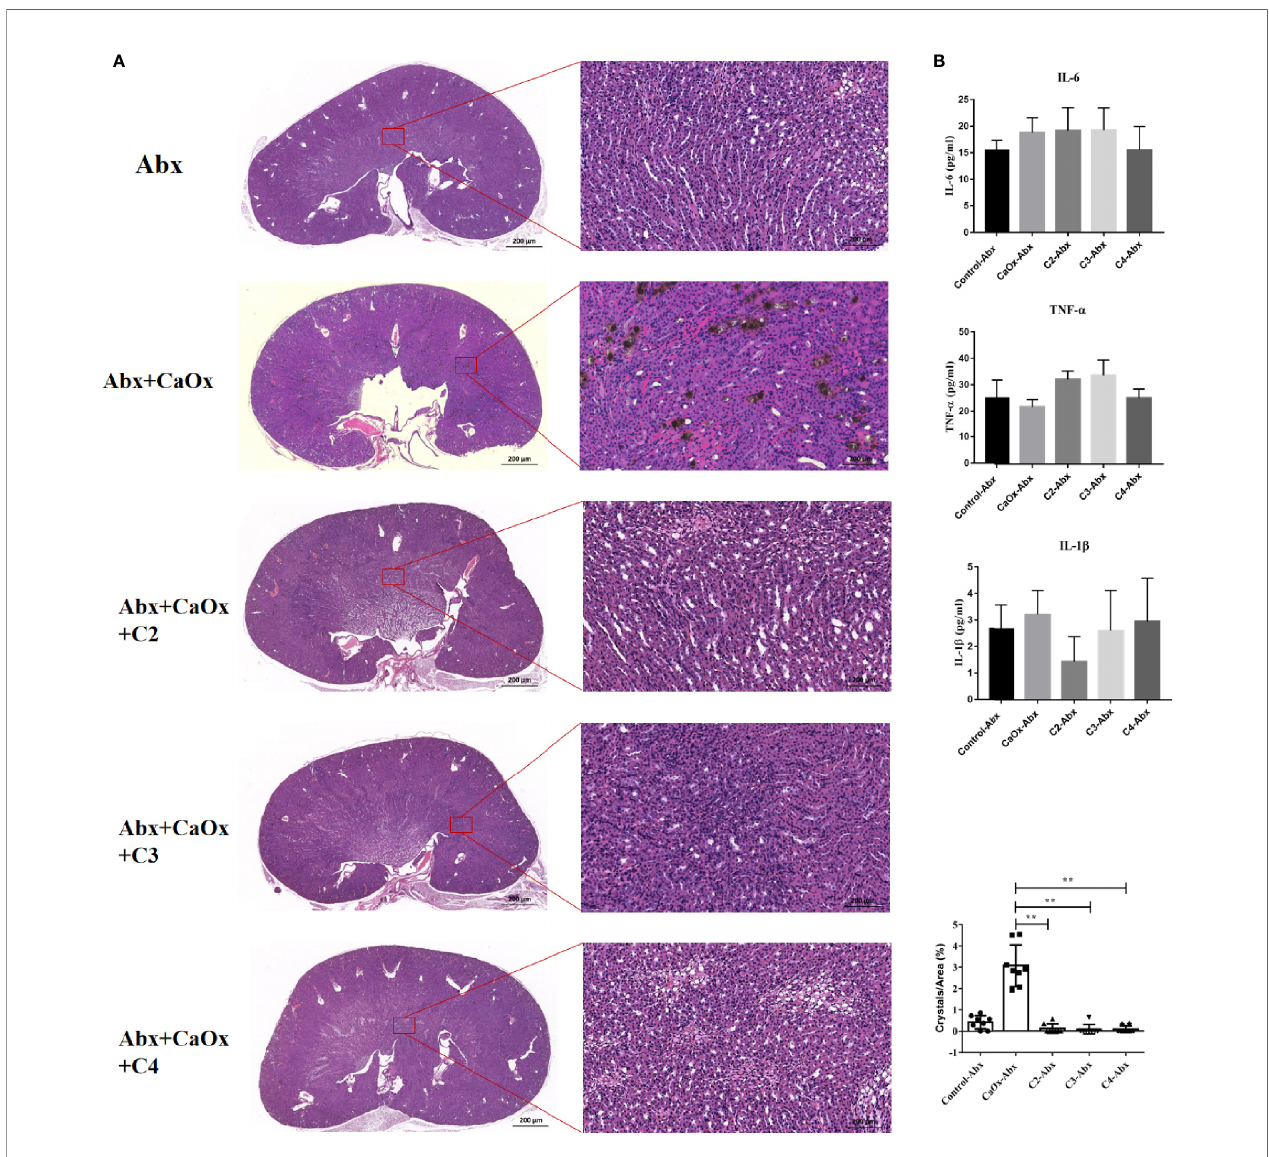
FIGURE 8 | Effect of antibiotics on renal CaOx crystal formation in mice with or without SCFAs. (A) Representative images of Von Kossa staining and HE staining in kidney of mice administrated with antibiotics and C2(acetate), C3 (propionate) and C4 (butyrate), respectively. (B) The level of serum IL-1 b , IL-6 and TNF- a . Data were shown as mean ± standard deviation. All data were analyzed by one-way ANOVA followed by Tukey ’ s multiple comparisons test among multiple groups. Statistically signi fifi cant was shown as **p <